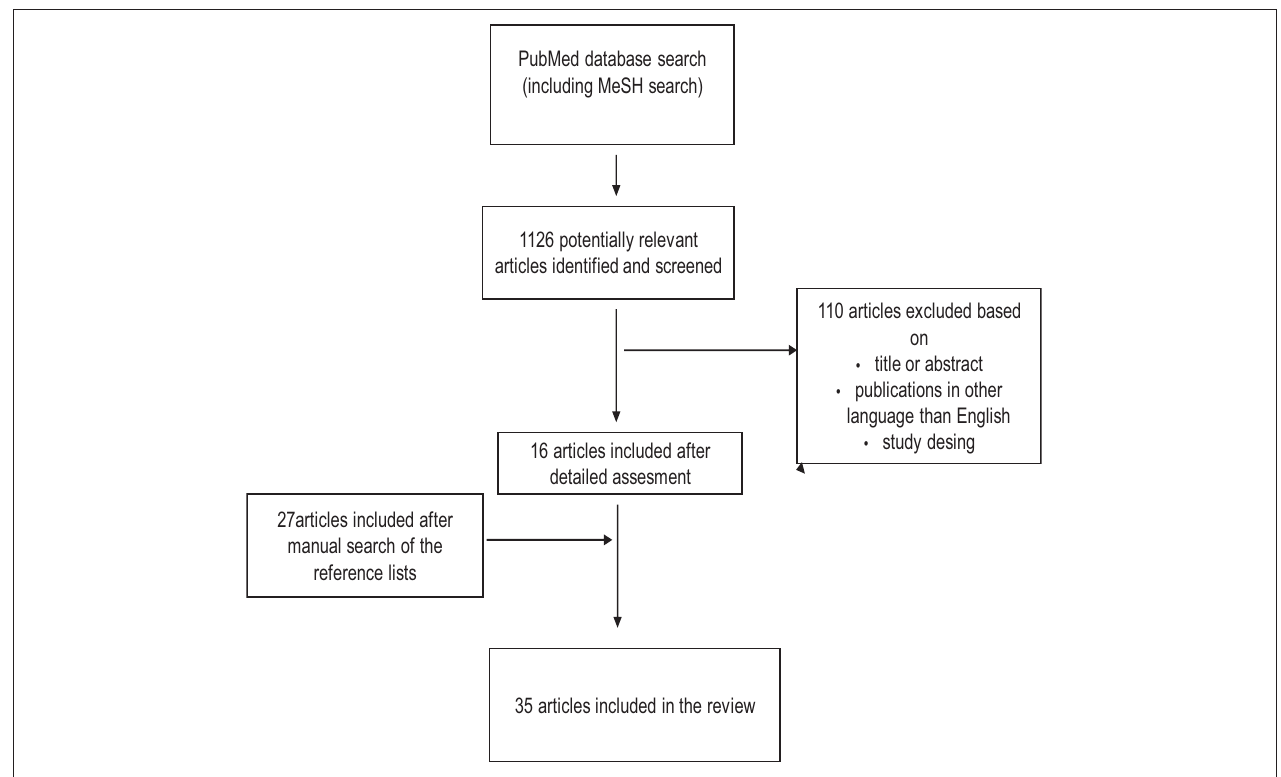
FIGURE 2 | Study selection process for articles about the association between abnormal placental and fetal blood flow and cognitive and neuropsychological outcome in preterm